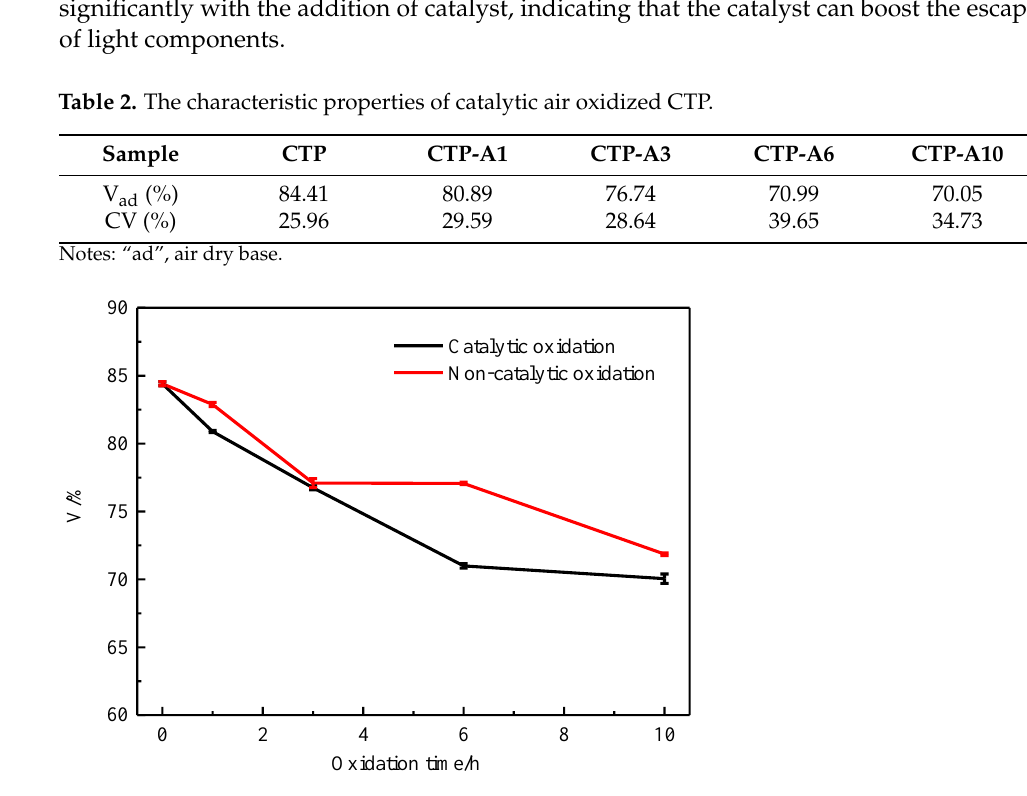
Figure 1. Changes of V content in CTP for catalytic oxidation and non-catalytic